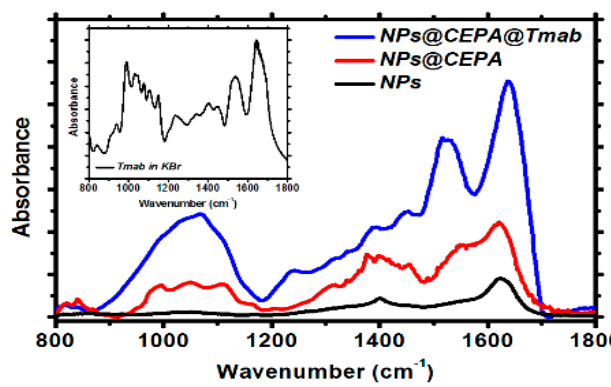
Figure 3. FTIR spectra for unmodified SPIONs (black curve), SPIONs modified with CEPA (red curve), and bioconjugated SPIONs (blue curve).